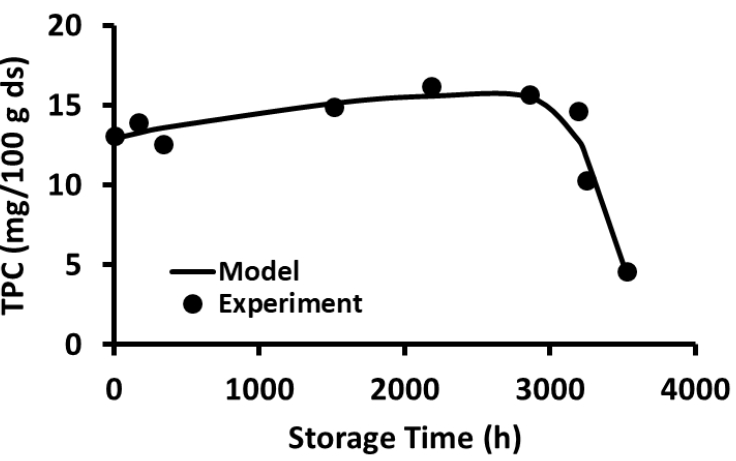
Figure 2. Polyphenol content during storage at 20 °C for 5 months.